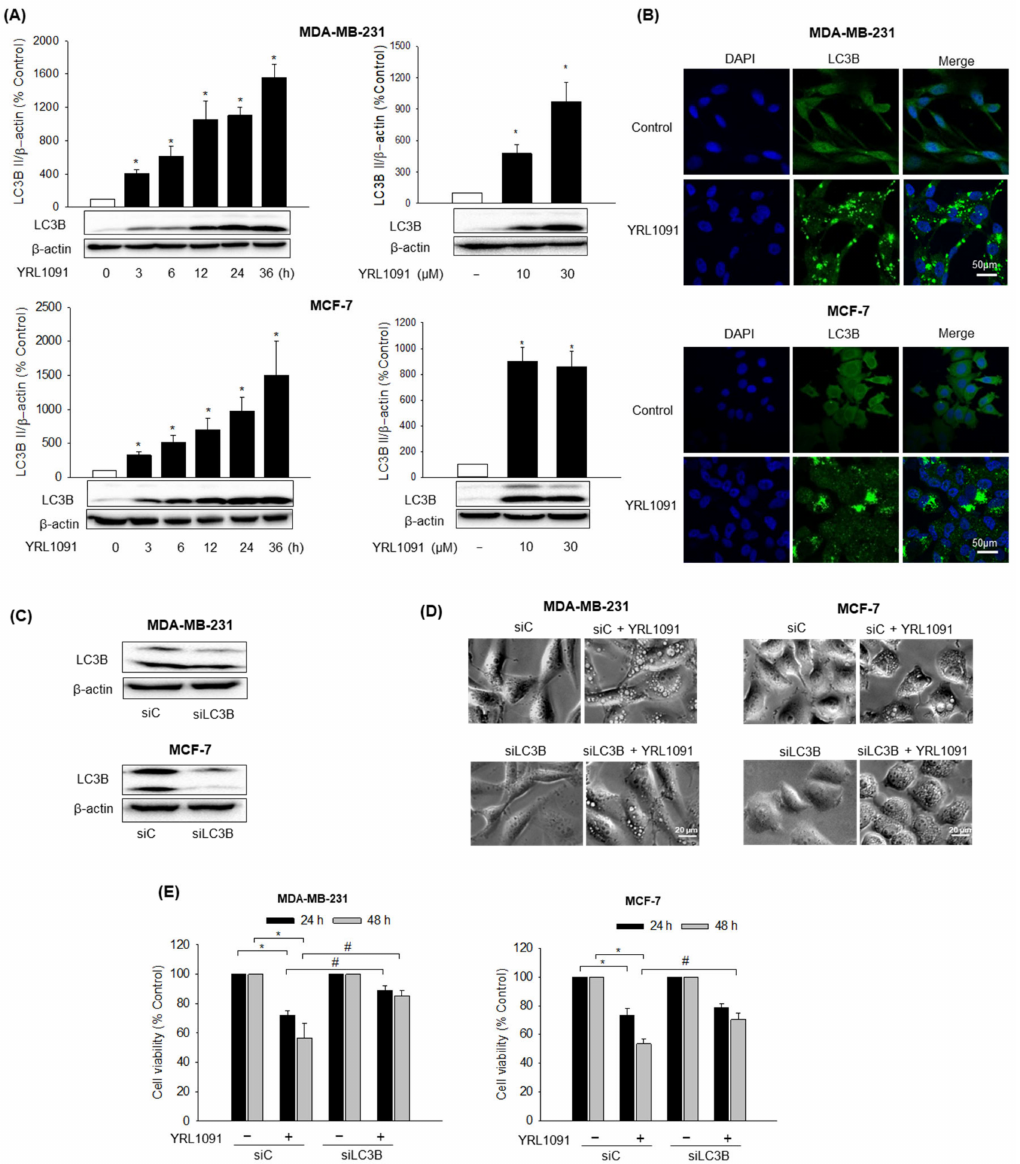
Figure 2. Role of LC3B in YRL1091-induced cytoplasmic vacuolization and cell death in MDA-MB-231 and MCF-7 cells. ( A ) Cells were challenged with 30 µ M YRL1091 for the indicated times (left) or 24 h at the indicated concentrations (right). The levels of LC3B expression were measured by western blotting, as described in Materials and Methods. β -Actin was used for normalization. Each data point was calculated as the percentage of protein level in vehicle-treated control cells. Representative bands from at least three independent experiments were shown. ( B ) Cells were treated with 30 µ M YRL1091 for 12 h and then stained with anti-LC3B antibody. Immunofluorescence images were obtained as described in Materials and Methods. Scale bar: 50 µ m. ( C – E ) Cells were transfected with either siC